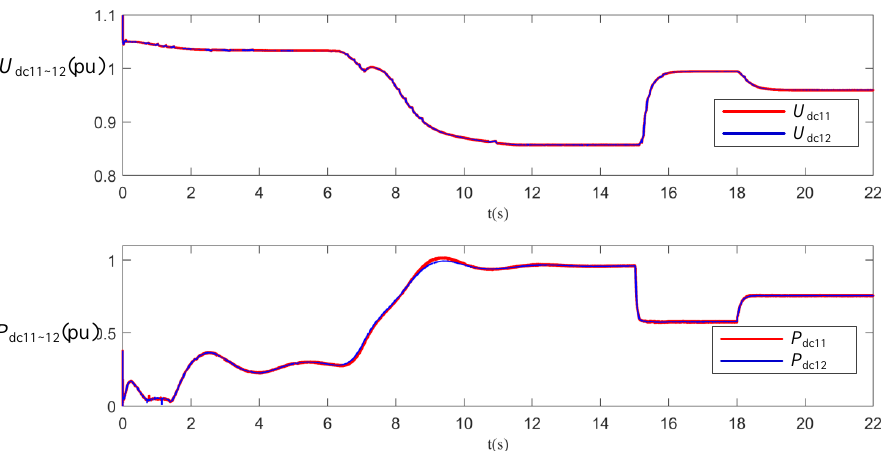
Figure 15. Primary side DC voltage and enable signal of original voltage loop and MPPT controller in boost converter 11.